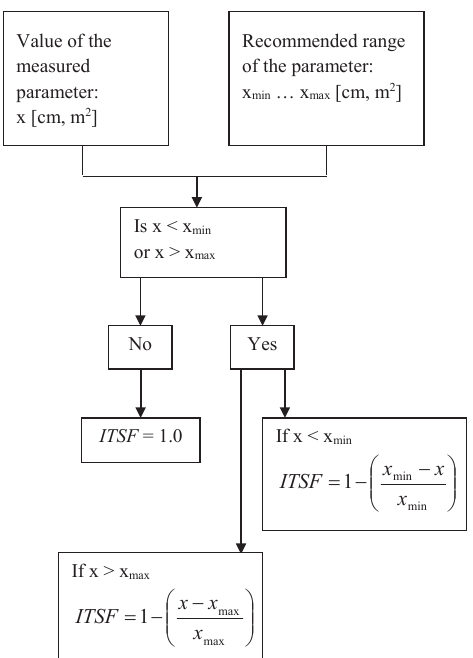
Fig. 1. An algorithm to calculate the value of the index of technical standards fulfilment (ITSF); the meaning of particular symbols is as follows: x = measured